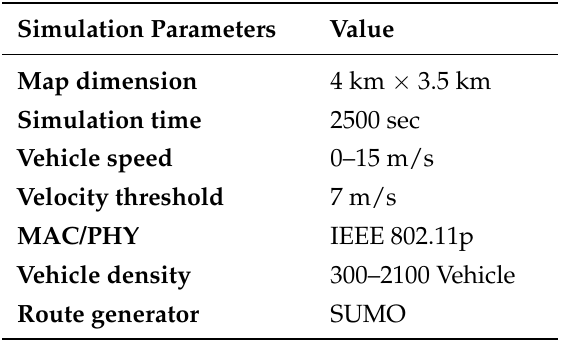
Table 1. Simulation parameters as configured in the SUMO implementation of Sheffield scenario.